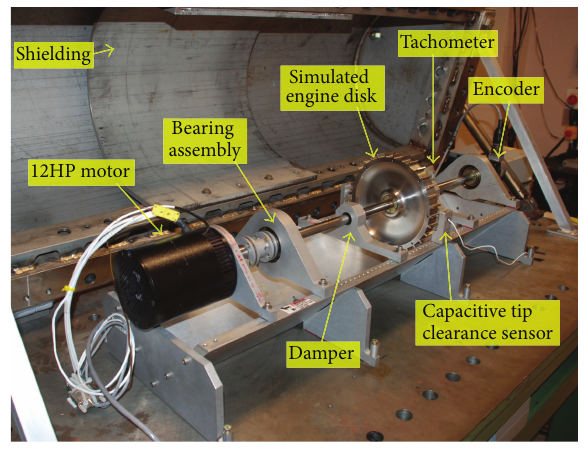
Figure 6: High Precision Spin Rig.